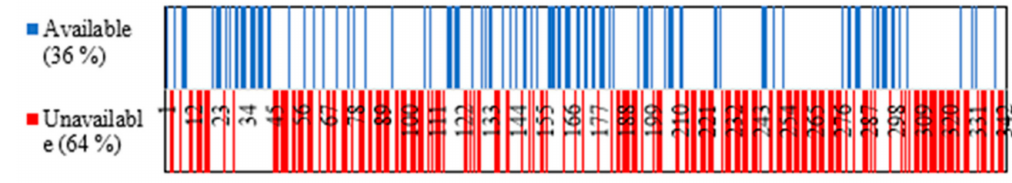
Figure 2. Distribution and dispersion of unavailable and available NDVI time series images of this study.